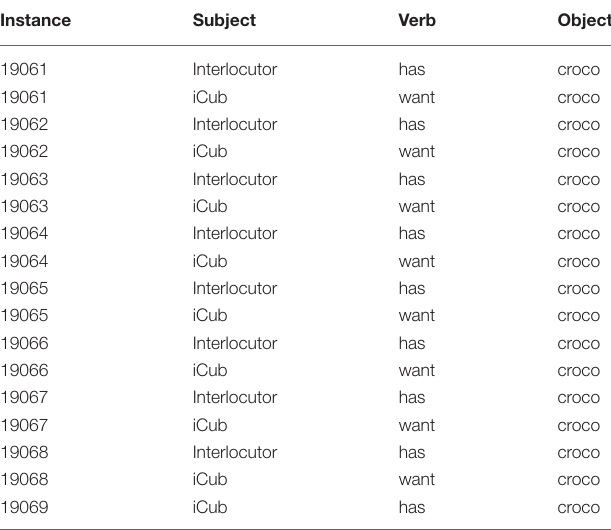
TABLE 6 | Secondary table specifying relations that will be used to create the Situation Model.